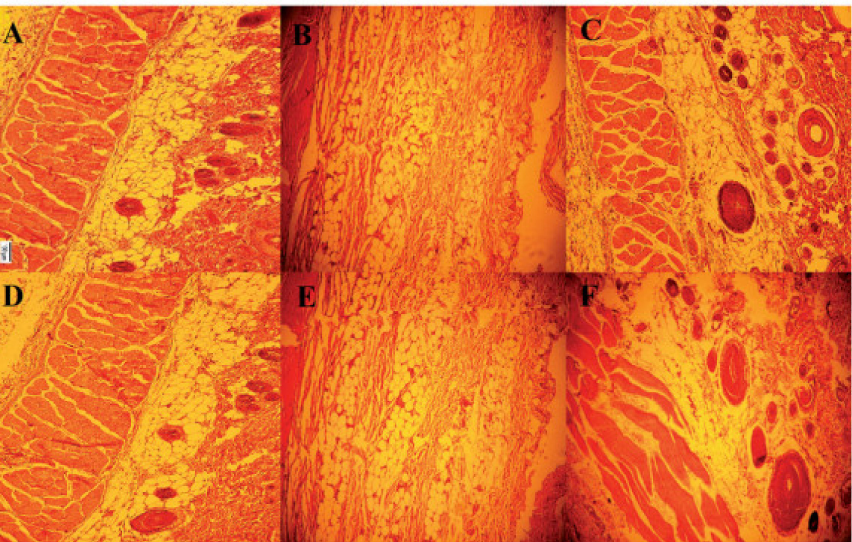
Figure 10. Histopathology images of the skin: (1) without a treatment after 7 days ( A ) and 21 days ( D ); (2) treated with caffeine hydrogel after 7 days ( B ) and 21 days ( E ); and (3) treated with caffeine-SLN- hydrogel after 7 days ( C ) and 21 days ( F ). Reproduced with permission from [476] [ Copyright Clearance Center], [Drug Development and Industrial Pharmacy]; published by [Taylor & Francis,